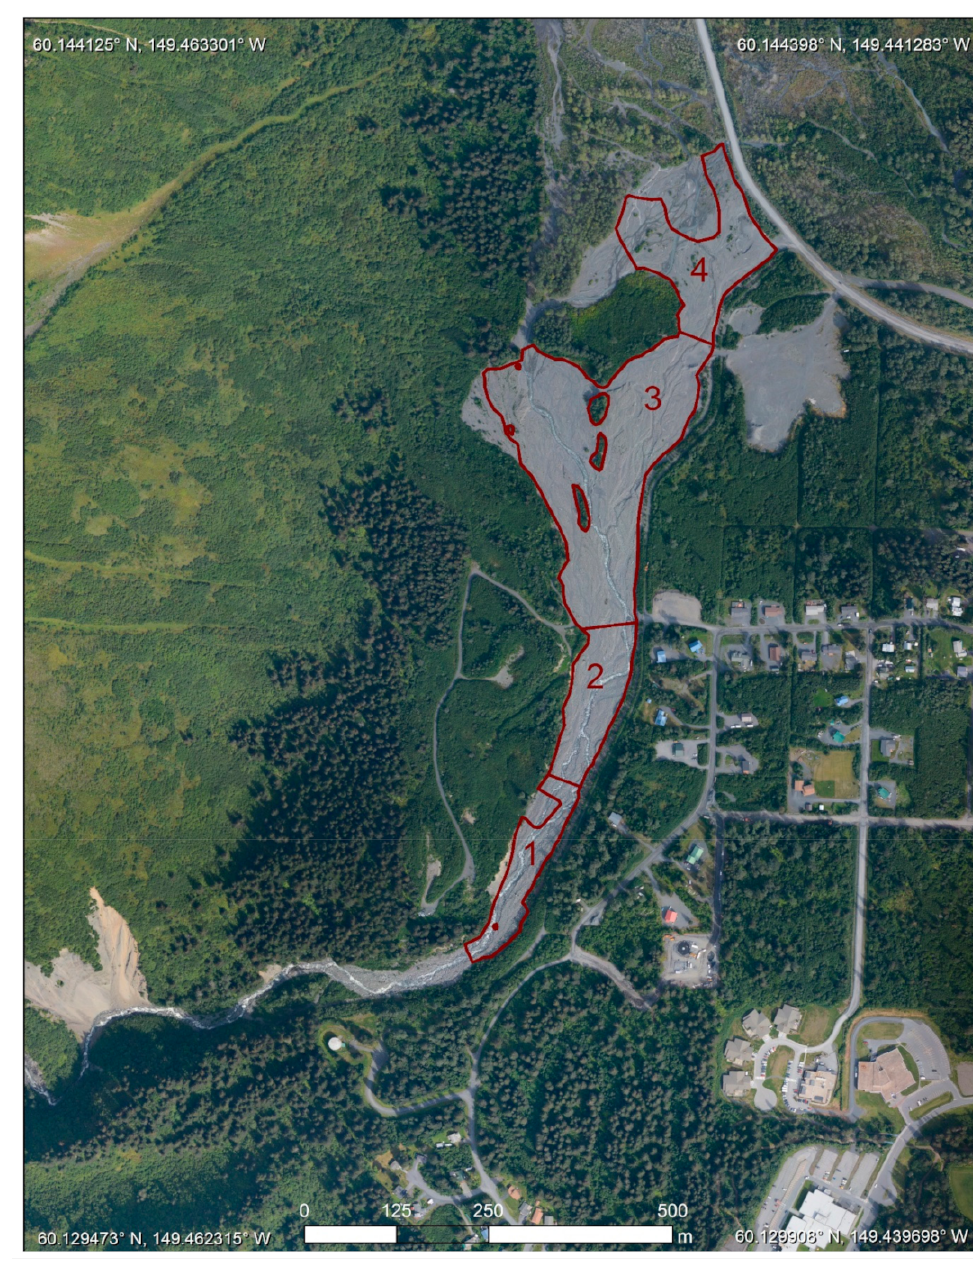
Figure 3. The Japanese Creek reserved stream corridor is broken up into four reaches. Reaches 1 and 2 are located upstream of the site of a previously existing bridge which was washed away in the flood of 2006 with 3 and 4 located downstream. The gaps in the area of analysis are due to the presence of vegetation, areas of unreliable data, or where data was not able to be collected. Of these areas, most are in areas that see little changes of sediment. As such, we only analyze the areas where all DEMs had valid elevation